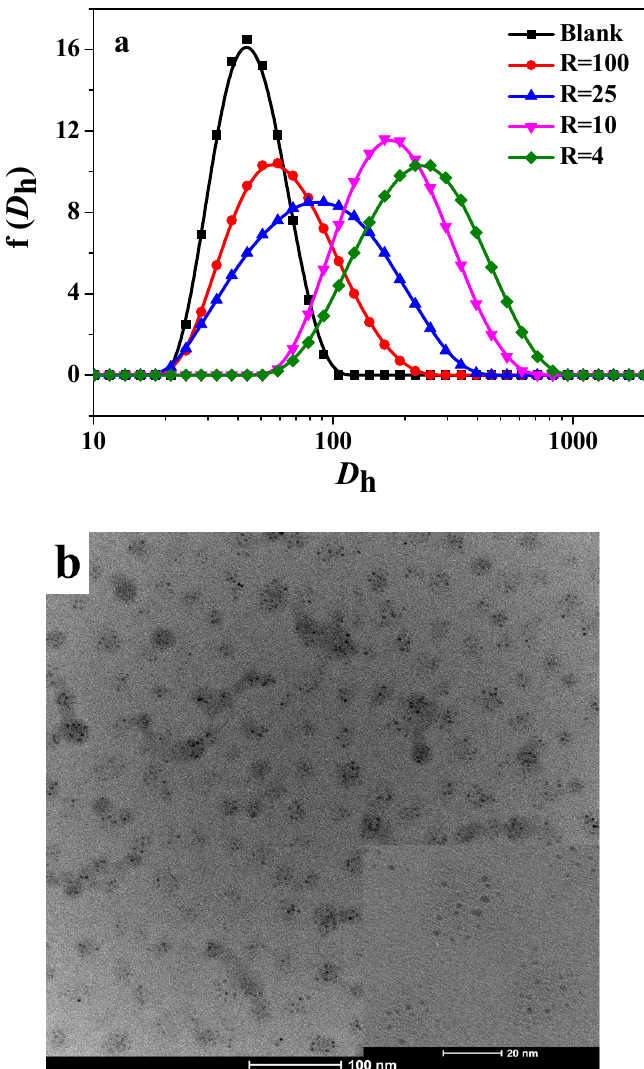
Figure 2. ( a ) Hydrodynamic diameter distribution of the micelles revealed by dynamic light scattering (DLS). ( b ) TEM images of polymeric micelle decorated with AuNPs, where R = 10. (DLS). ( b ) TEM images of polymeric micelle decorated with AuNPs, where R = The catalytic reaction is one of the most important applications of AuNPs. Reduction of 4-nitrophenol (4-NP) to 4-aminophenol (4-AP) is a well-known catalytic reaction used to examine